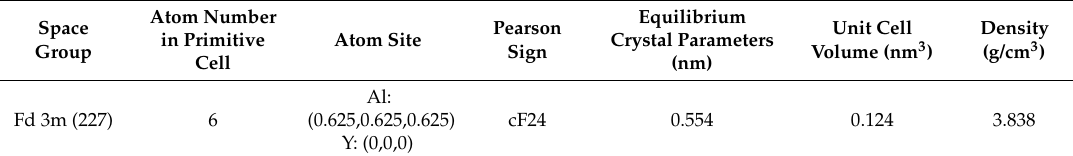
Figure 10. Flow chart of solid solution of the Mg-Li alloy.